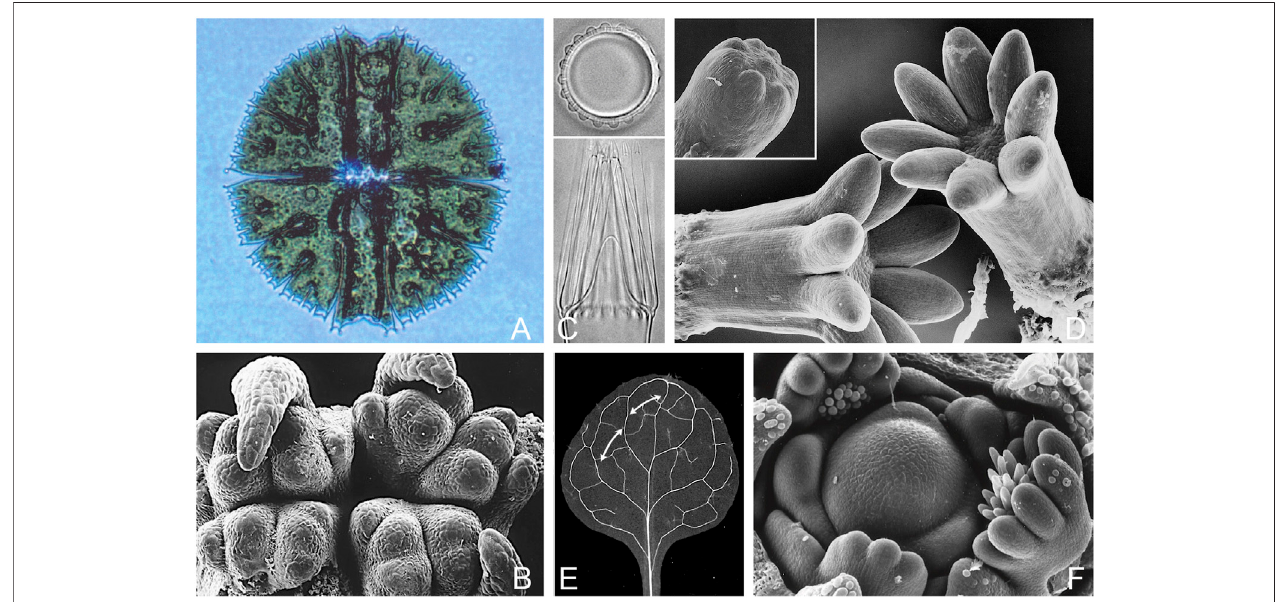
FIGURE 1 | Turing-type patterns in plants: branching and whorl formation in uni- and multicellular examples, and leaf venation. (A) . Dichotomous branching in one dimension:thefreshwaterdesmid Micrasteriasrotata ,(celldiameter230 μ m)whereformisgeneratedfollowingcelldivisionbybranchingtipgrowthalongtheedgeofthe expanding semicell. The effective pattern scale (wavelength) declines during this process from ca. 30 μ m at the beginning to 5 μ m for the distal branches; see Lacalli & Harrison (1987) for quantitative details. (B) . Alternating dichotomous branching in two dimensions: the shoot apex of Psilotum nudum , a basal fern whose simple aerial shoots originate through repeated dichotomous branching and only elongate, together, secondarily. Distance between adjacent primordia at this stage is in the 150 – 200 μ mrange(Takiguchietal.,1997),butthepatternwavelengthhasnotbeenmeasuredthroughthebranchingsequence,andcouldwellvary;specimensupplied byT.A.Steeves. (C) .Whorlformationinasinglecell:thepatternofhairinitials(top)andtheiroutgrowth(bottom)inthedasycladalga Acetabularia .Thedistancebetween initials, typically 20 μ m in culture, can range between 16 and 28 μ m in a predictable way depending on temperature and calcium concentration, and from this one can makeusefulinferencesaboutthemechanism;seeHarrison&Hillier(1985),Dumais&Harrison(2000)fordetails. (D) .Whorlformationinconifers:thecotyledons(primary needles) of cultured white spruce embryos; stem diameter is ca. 750 μ m compared with 400 μ m when the initials are fi rst evident (inset), with a spacing of ca. 95 μ m (Fowke et al., 1994). The most detailed statistical information available on cotyledon spacing is for larch, where the pattern wavelength has been measured precisely, at 98±4 μ m(Harrison&vonAderkas,2004;Hollowayetal.,2018). (E) .Leafvenationinayoung Arabidopsis leaf,wheredistancebetweensecondaryveins(arrows)inpart re fl ects a spacing mechanism that acts along the leaf margin as the primordium develops. The leaf blade is ca. 2 mm long at the stage shown, but the fi rst secondary veins appear when it is 20-fold smaller (100 – 120 μ m long) with an effective wavelength between secondaries as they develop in the 20 μ m range, down to a few cell diameters (10 – 15 μ m) in some instances (Scarpella et al., 2006, Wenzel et al., 2007, Verna et al., 2019; see Holloway & Wenzel, 2021 for relevant modeling). The mechanisticbasisofthediscrepancybetweenvascularpatterningatthisscaleandthatofprimordiaacrosstheapicalmeristemisasyetunresolved. (F) .Theshootapical meristem of lupin ( Lupinus polyphyllus ), one of the largest among the angiosperms, with a central dome ca. 250 μ m across at its base. The overall pattern of primordia, typical of angiosperms (with some exceptions, e.g., of decussate pattern), is one of spiral phyllotaxy, but the leaves are palmate, developing as partial whorls as can be seen here in three examples, where spacing would appear to be on a scale somewhere below 30 μ m; see Runions et al. (2017) for a further discussion of leaf shape in relation to spacing mechanisms acting along the leaf margin. Photo credits: (A, B) T. C. Lacalli, (C) Jacques Dumais, (D) L. C. Fowke, (E) Enrico Scarpella, (F) V. K.